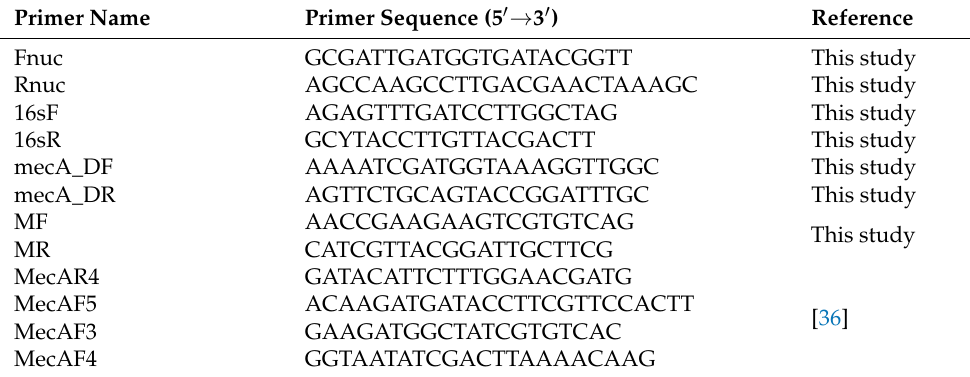
Table 3. The primers used for PCR amplification and DNA